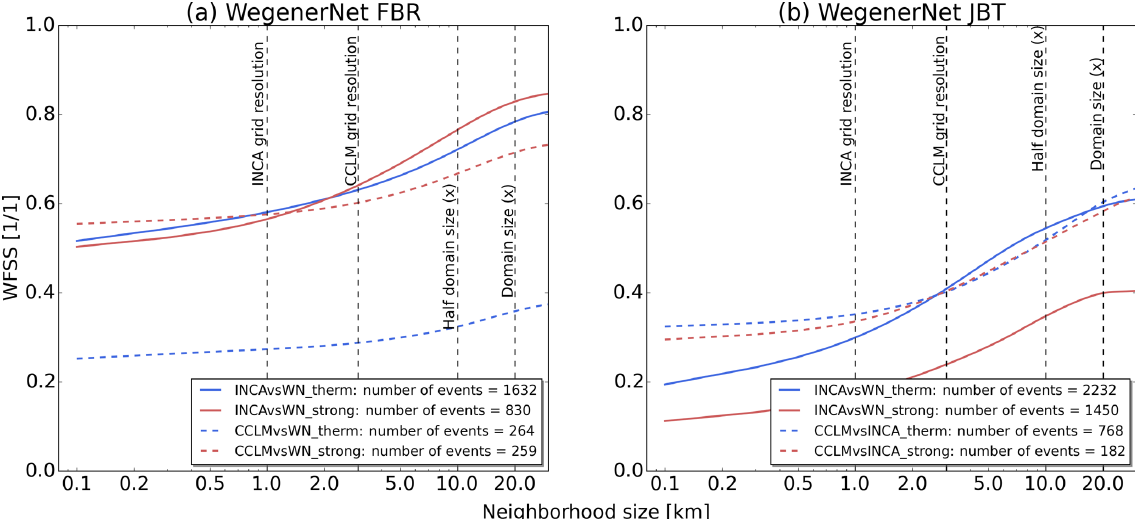
Figure 3. The event-averaged wind fractions skill score (WFSS) results for the WegenerNet FBR (a) , compared to the WegenerNet JBT (b) , for the four defined evaluation cases in each region (see legend; indicating also the number of events included). See Table 1 for more information on the evaluation